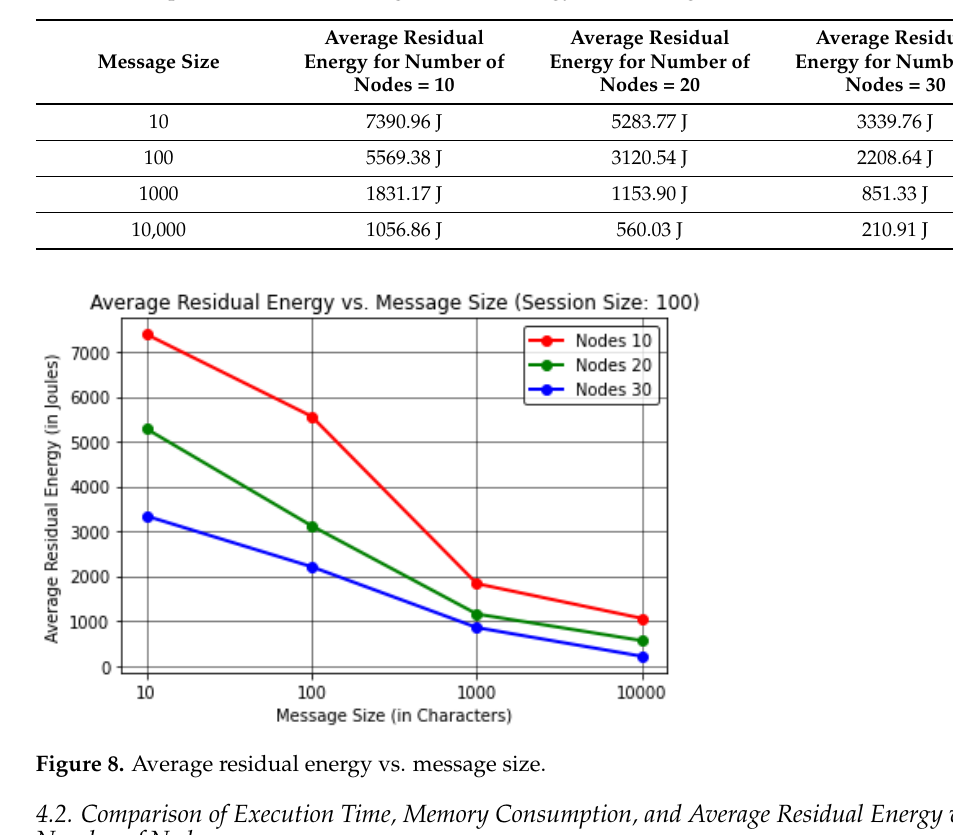
Table 5. Comparison between average residual energy and message size.